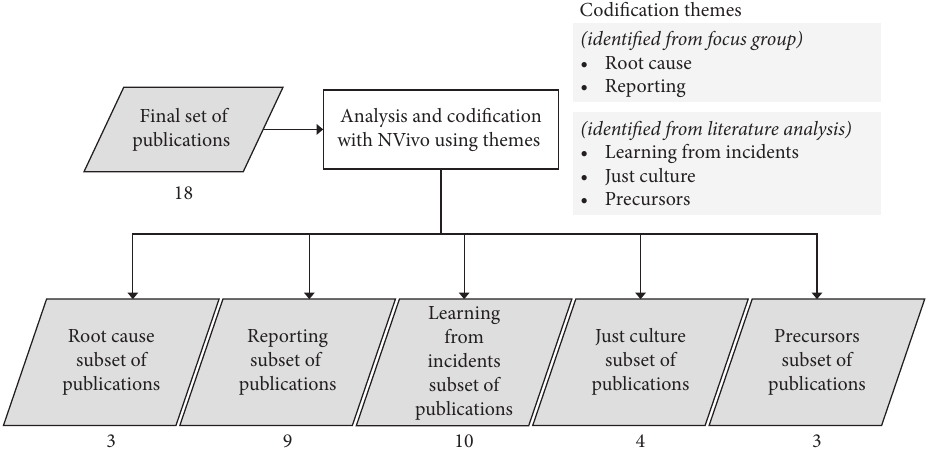
Figure 3: Distribution of the final set of 18 publications in the five codification themes following the NVivo analysis and codification step of the systematic review process. Table 4: Mapping of 18 publications (final set of publications) against the five codification